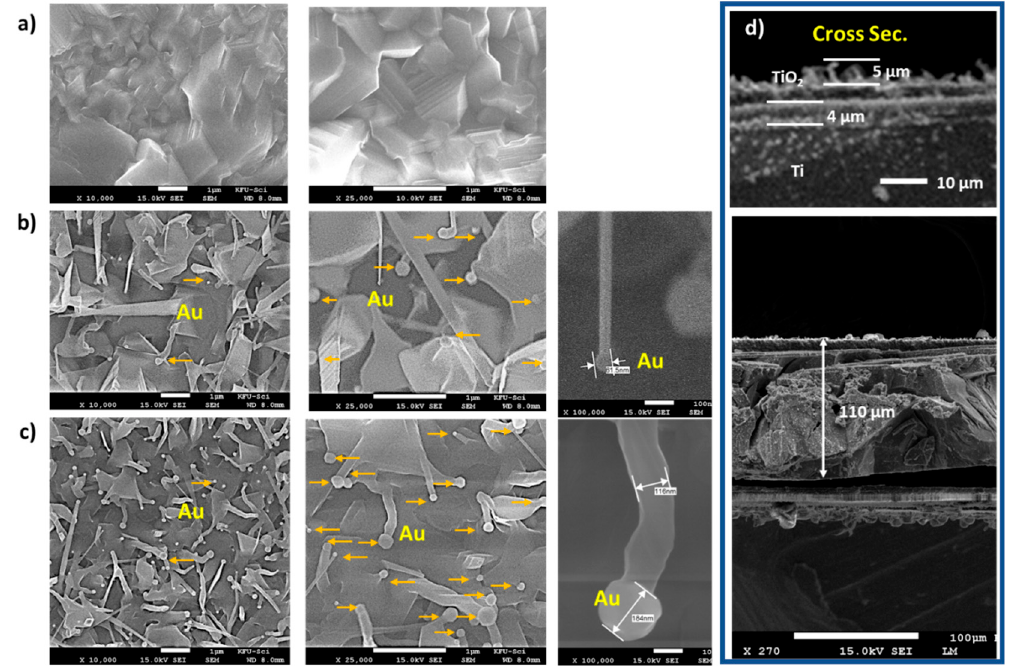
Figure 2. FESEM images of Au/TiO2: ( a ) pure TiO2, ( b ) Au1/TiO2, ( c ) Au2/TiO2 samples, and ( d ) the cross-sectional image of the prepared TiO2.